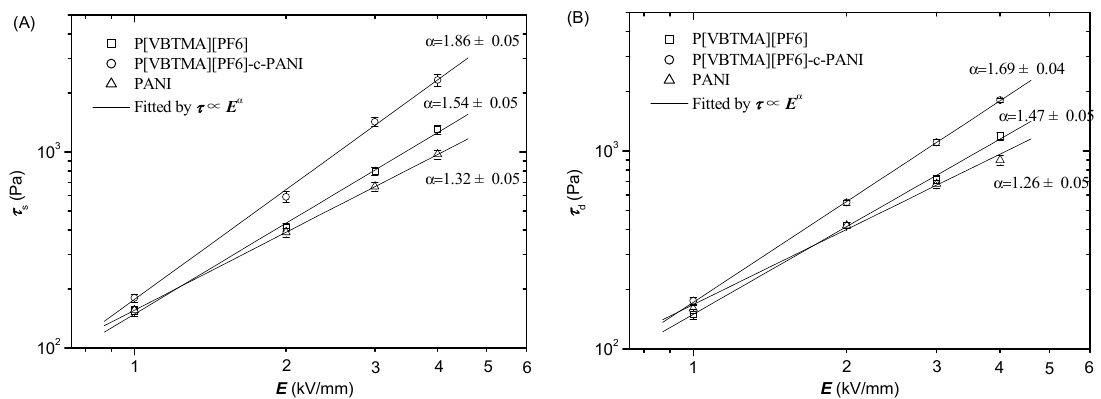
Figure 5. Static yield stress ( A ) and dynamic yield stress ( B ) as a function of electric field strength for ER suspensions: P[VBTMA][PF 6 ], P[VBTMA][PF 6 ]-c-PANI (40 wt %), and PANI ( φ = 27 vol %, T = 23 °C).